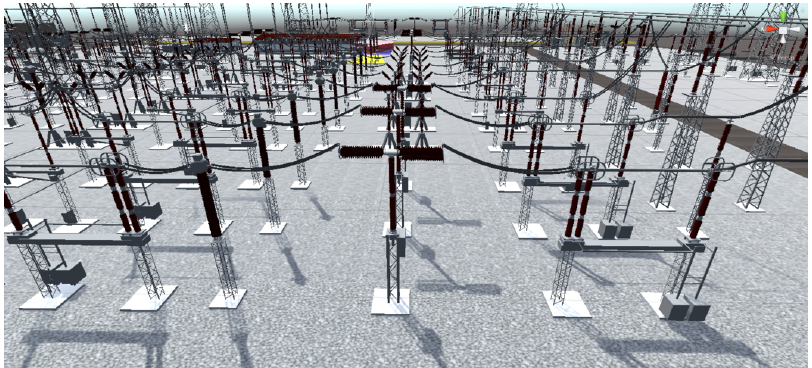
Figure 10. Power substation virtual environment.